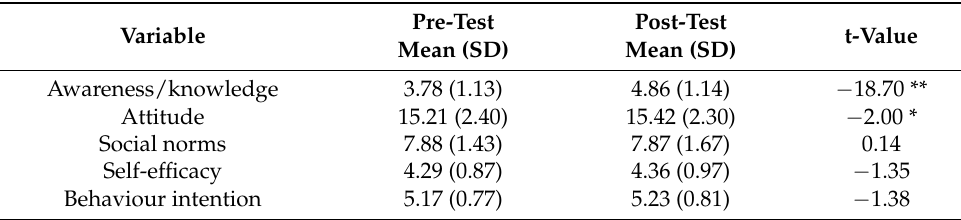
Table 4. Awareness/knowledge, attitudes, social norms, self-efficacy, and behaviour intentions of the entire sample.